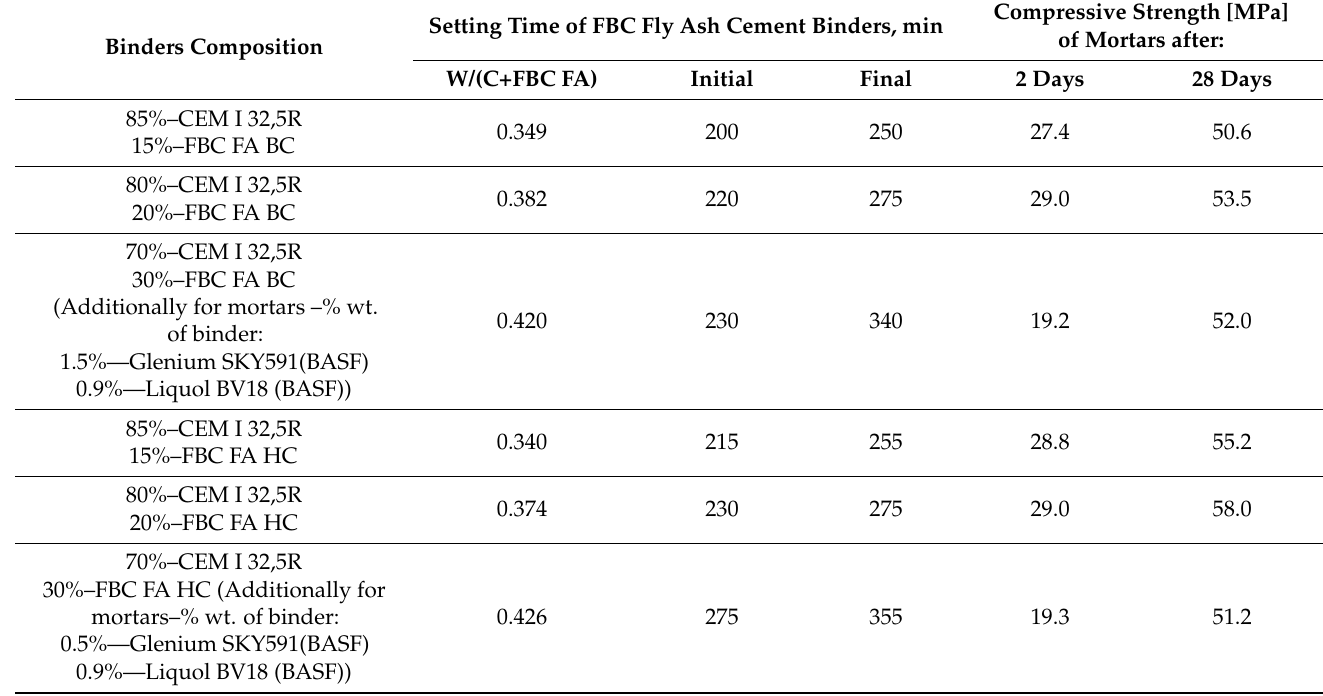
Table 6. Composition and properties of FBC fly ash-cements